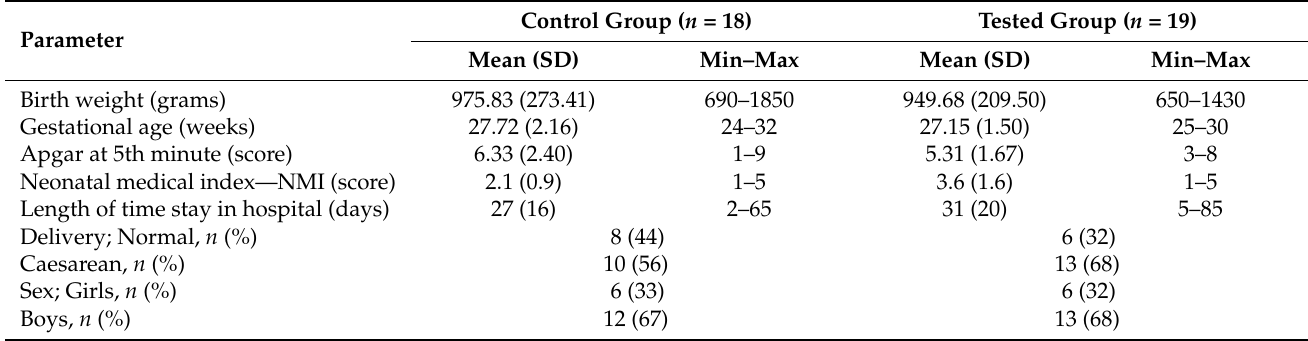
Table 1. Characteristics of the control group and tested